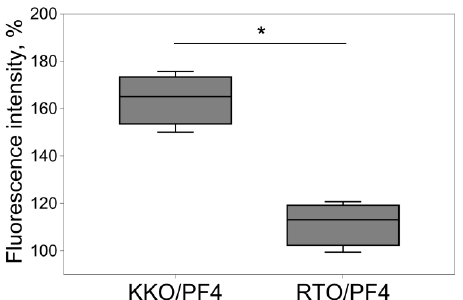
Figure 5. Fluorimetric analysis of calpain activity in platelets that were incubated for 180 min with a mixture of 10 μg/mL PF4 + 50 μg/mL KKO or RTO. The numbers that characterize the calpain activity were normalized by the corresponding negative control (untreated platelets) taken as 100%.